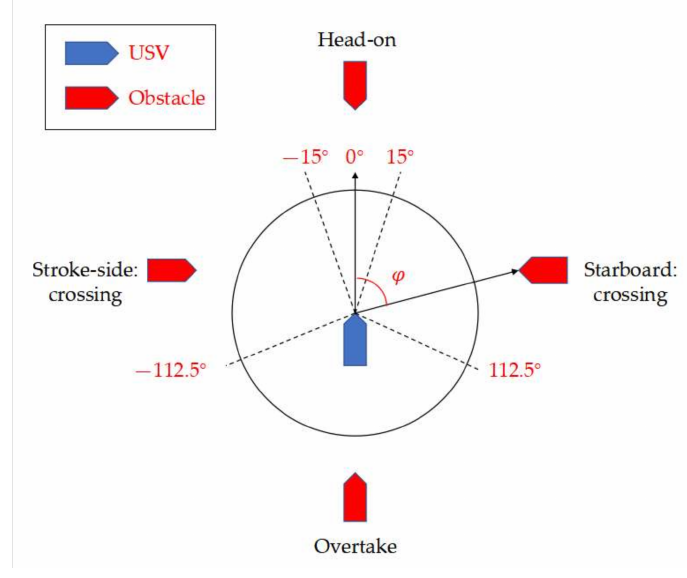
Figure 3. The relative bearing from the obstacle ship to the USV.